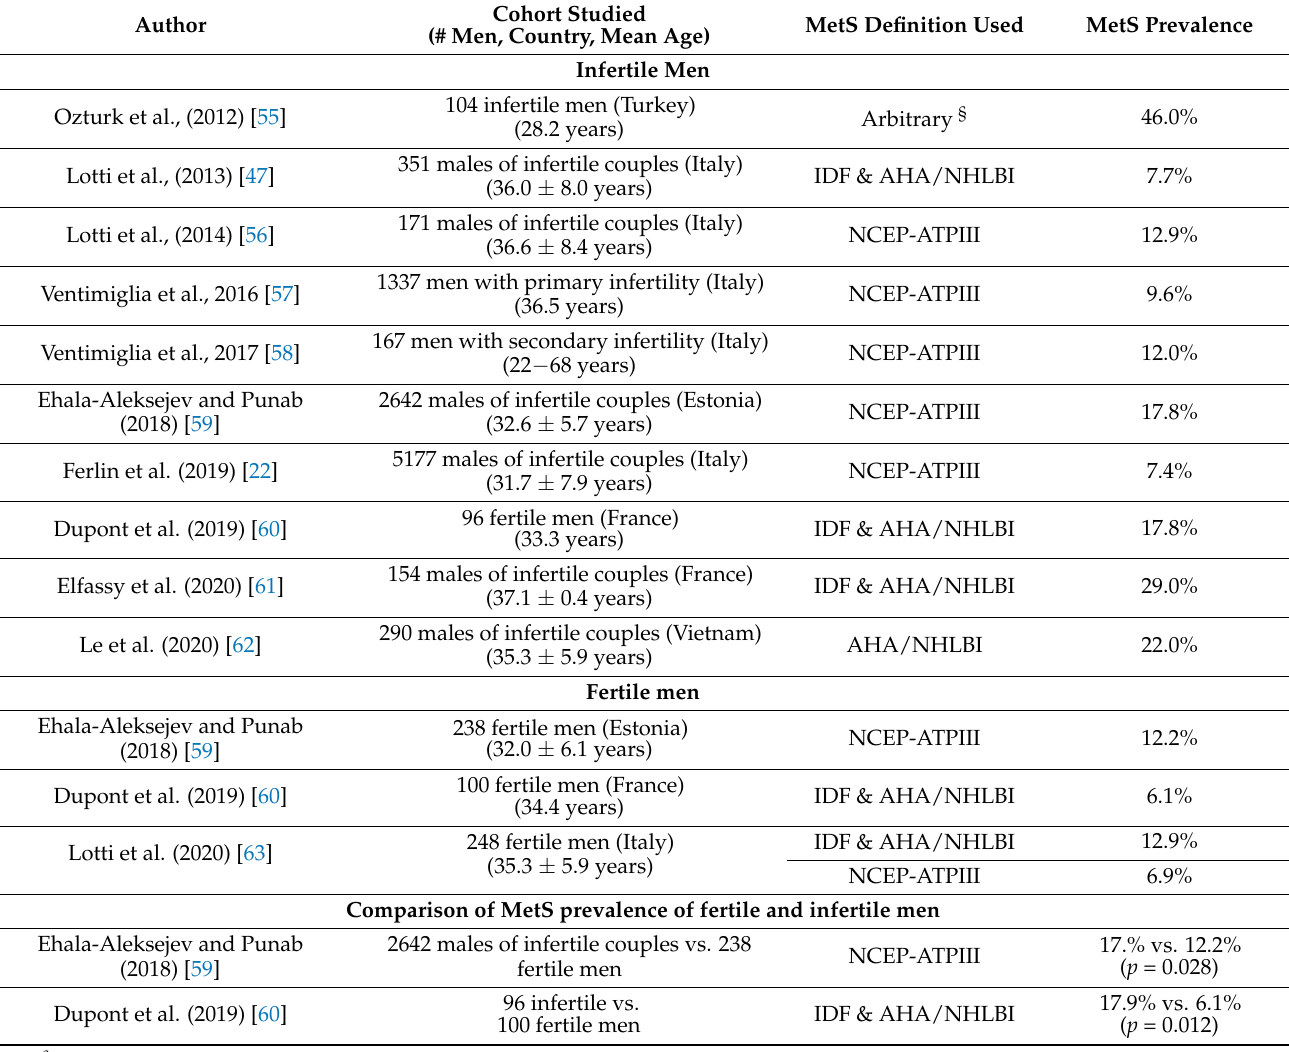
Table 2. Prevalence of metabolic syndrome (MetS) in infertile and fertile